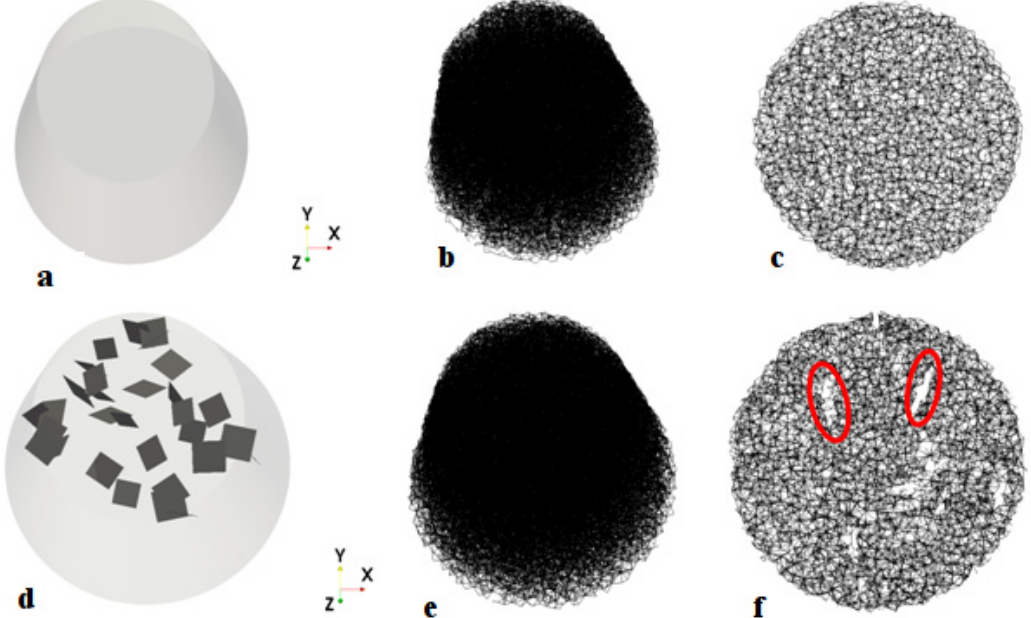
Figure 6. ( a ) Homogeneous specimen without micro-cracks. ( b ) the bond network of the homogeneous specimen ( c ) a slice-cut of the bond network of the homogeneous specimen ( d ) specimen with micro-cracks. ( e ) the bond network of the specimen with micro-cracks ( f ) a slice-cut of the bond network of the specimen with micro-cracks.